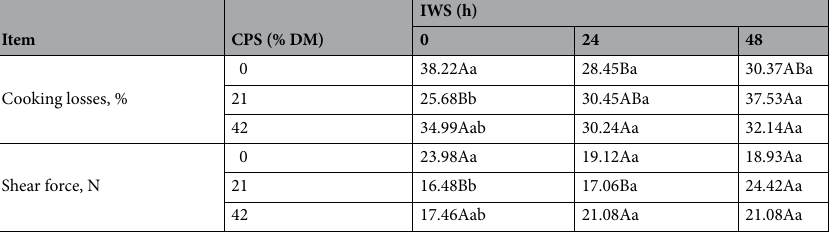
Table 5. Interaction between cactus pear silage (CPS) and submitted to intermittent water supply (IWS). A,B ,a,b Different letters within a row with uppercase and within a column with lowercase are significantly different by Tukey test ( p <